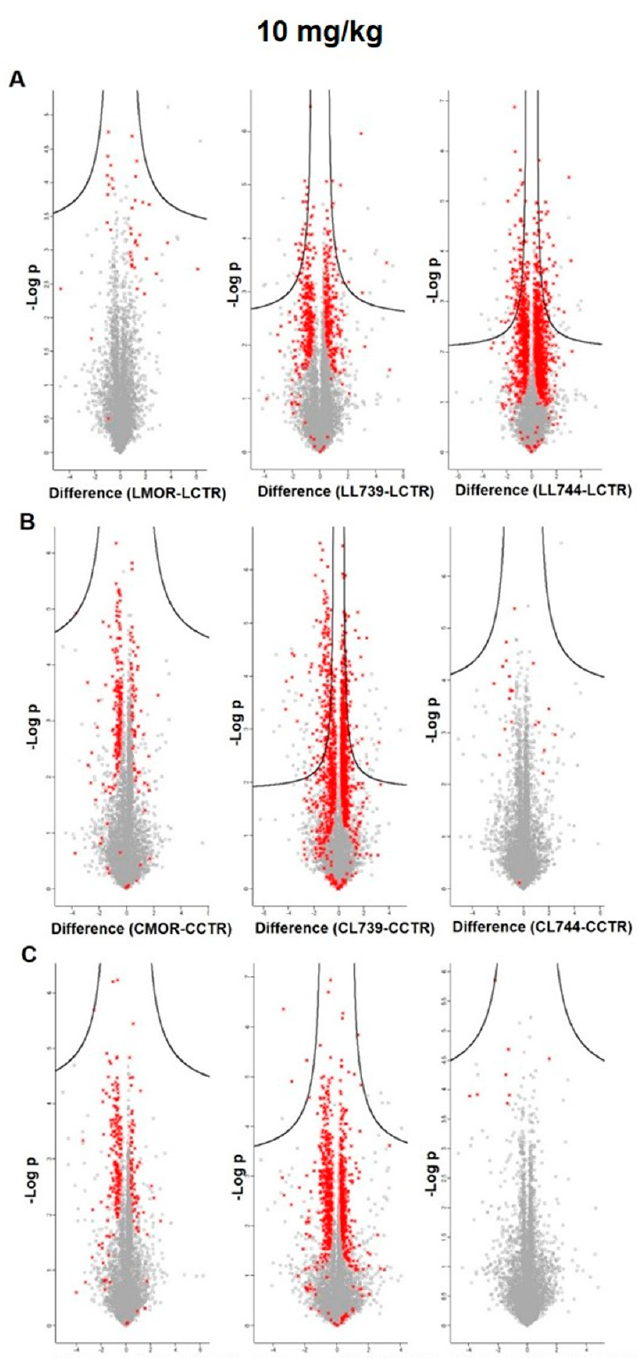
Figure 7. Volcano plots indicating significantly altered proteins identified in rat spleen lymphocytes ( A ), brain cortex ( B ), and hippocampus ( C ) after 7-day treatment with 10 mg/kg of morphine ( MOR , left panels), LYS739 ( middle panels), and LYS744 ( right panels). Significantly altered proteins are labeled in red (the star symbols); performed with Perseus software version 1.6.15.0. L739, LYS739 ; L744, LYS744 .